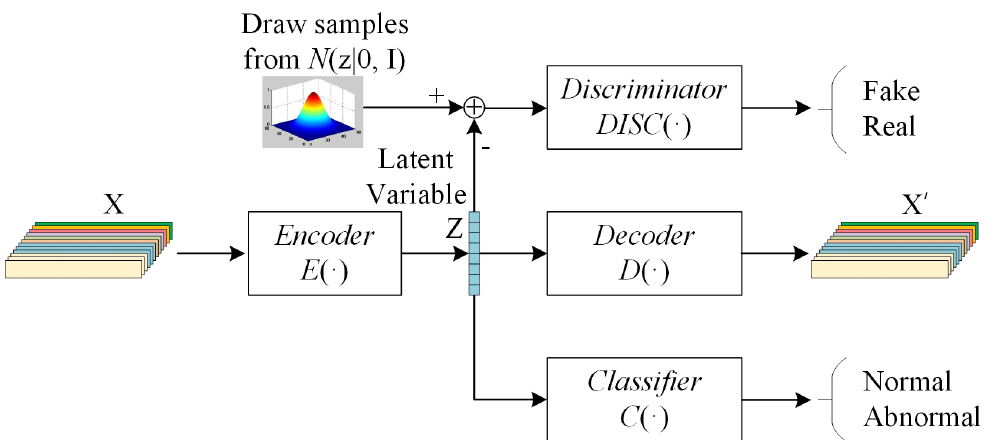
Figure 5. Framework of Semi-Supervised Deep Neural Network.